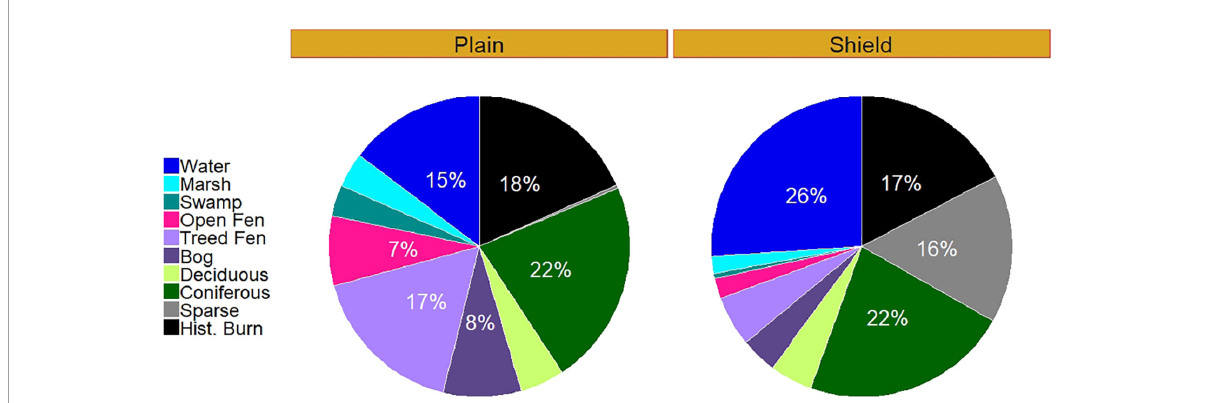
FIGURE2 Pie charts showing distribution of ecotypes on the Taiga plains (left) and Taiga shield (right) for the study area.